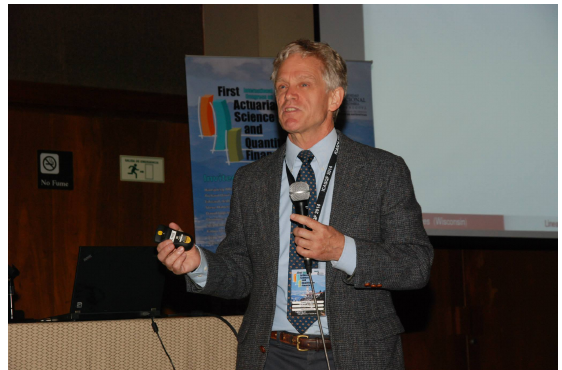
Figure 2: Jed enjoys presenting his work. This is at the First International Congress on Actuarial Science and Quantitative Fi- nance, 2014, Bogotá,